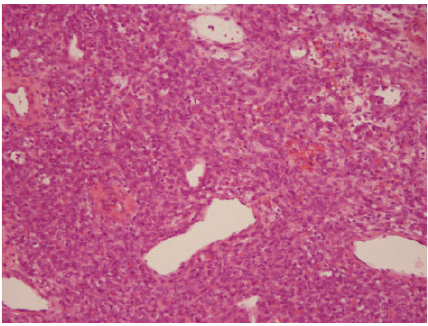
Figure 2: Many round to fusiform tumor cells surrounded the capillaries (Hematoxylin/eosin, ×